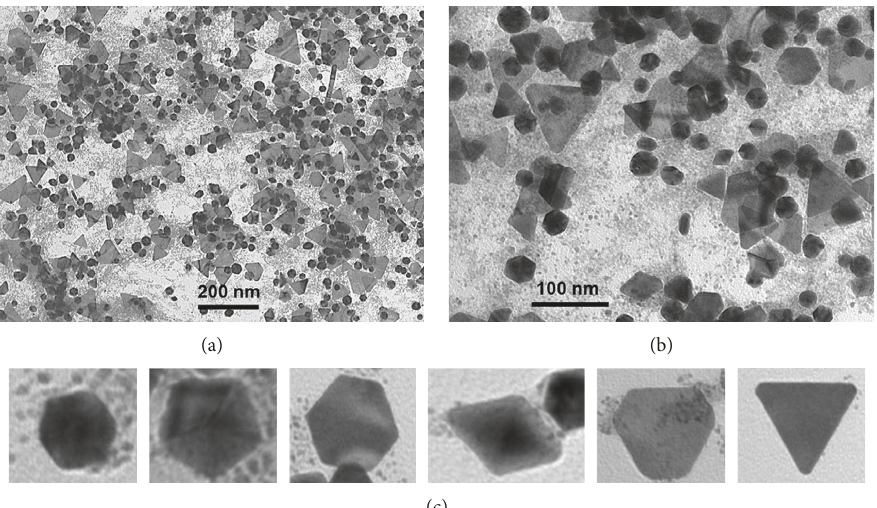
Figure 1: (a) TEM image of a typical distribution of AuNPs (molar ratio R of a region of (a) where the small spheroidal nanoparticles are evidenced; (c) the most frequent shapes of the bigger nanoparticles.